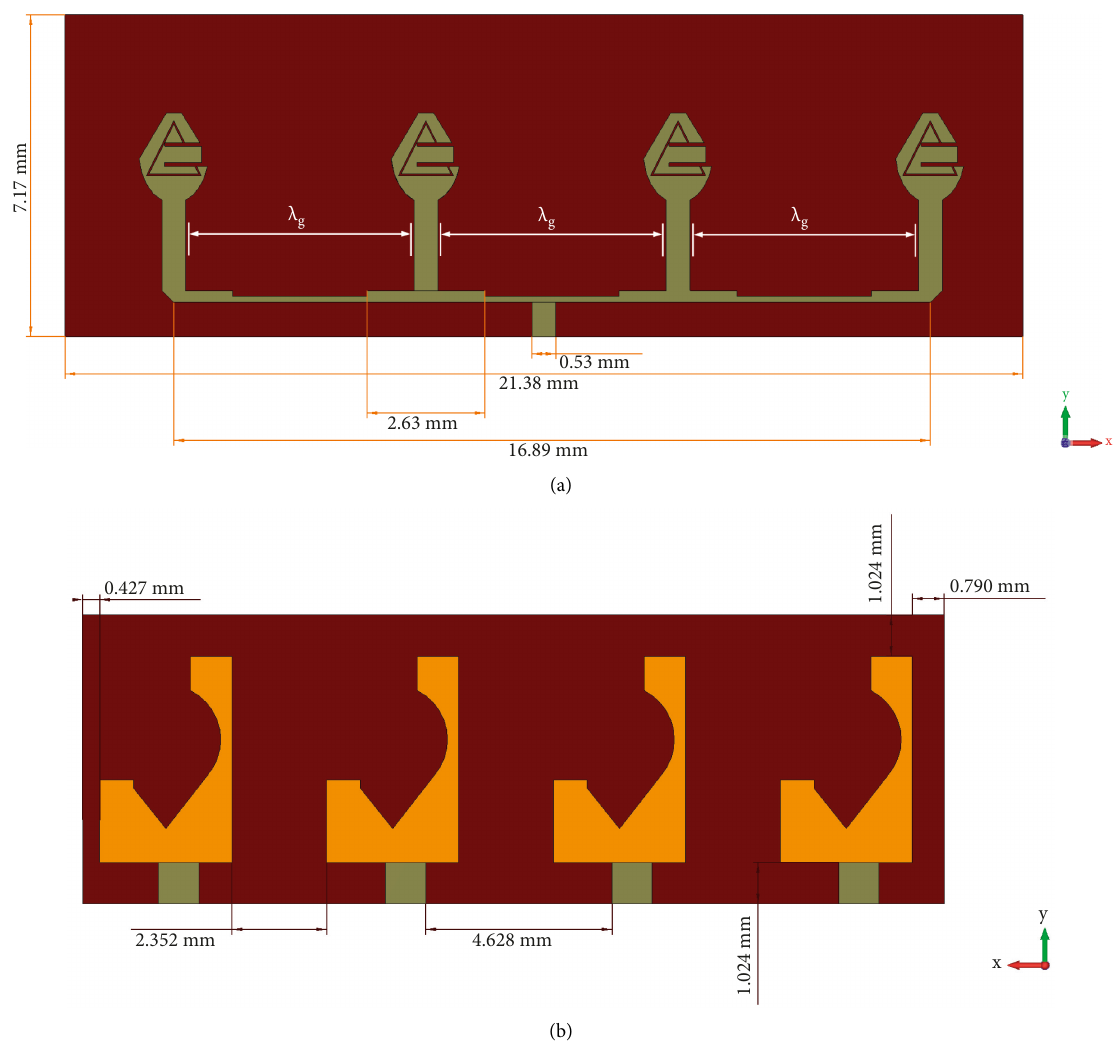
Figure 17: Design parameters.